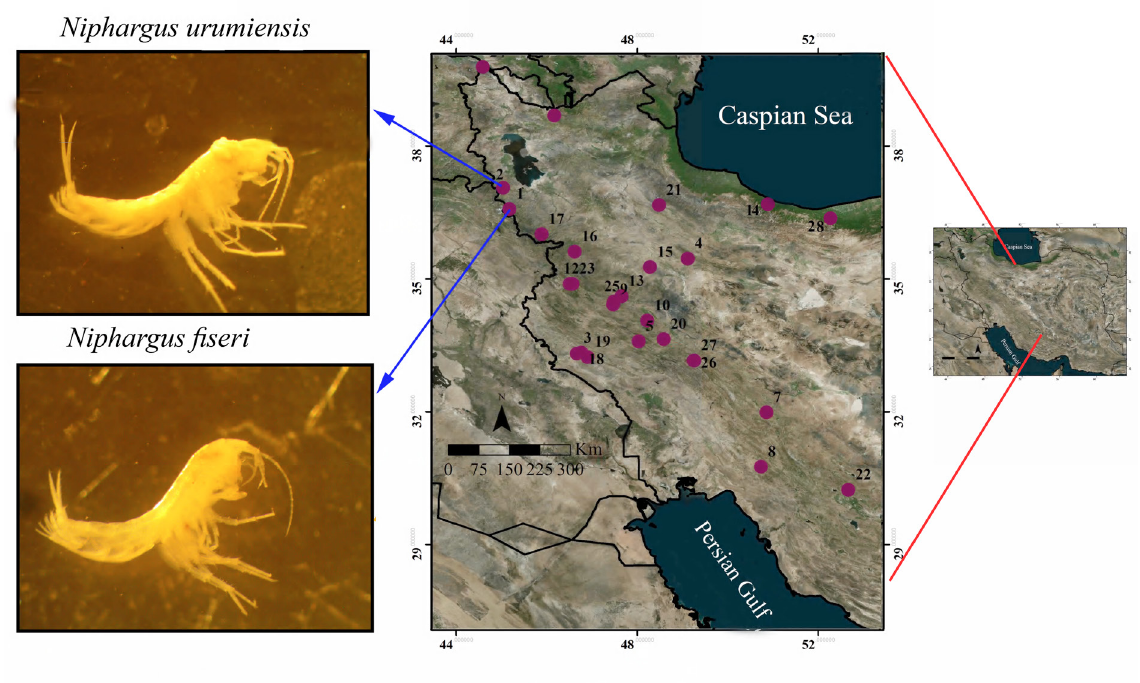
Fig. 1. Distribution map of the species of Niphargus Schiödte, 1849 in Iran. Localities are labelled as: 1. N. fiseri sp. nov. 2. N. urmiensis sp. nov. 3. N. sarii Esmaeili-Rineh, Mohammad-Niakan